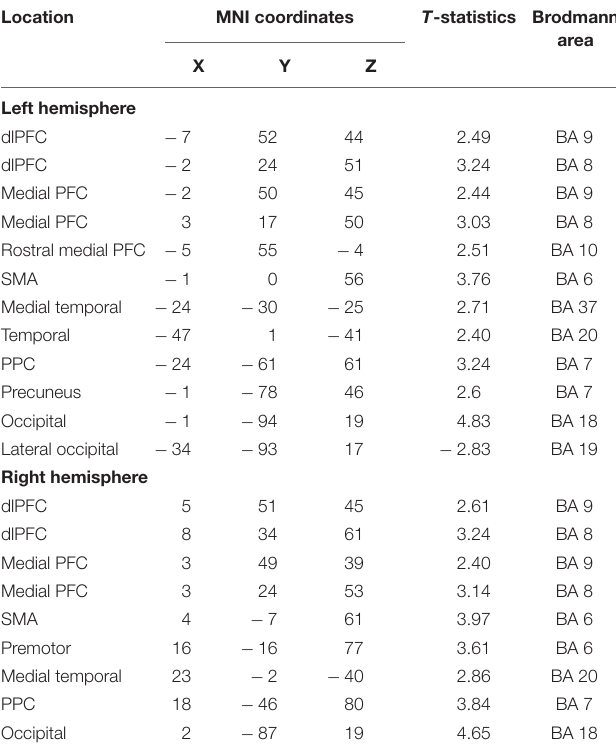
TABLE 1 | Maxima of regions showing significant differences between the Updating and control locations in the source space during the component P1N1 of the RotEP.